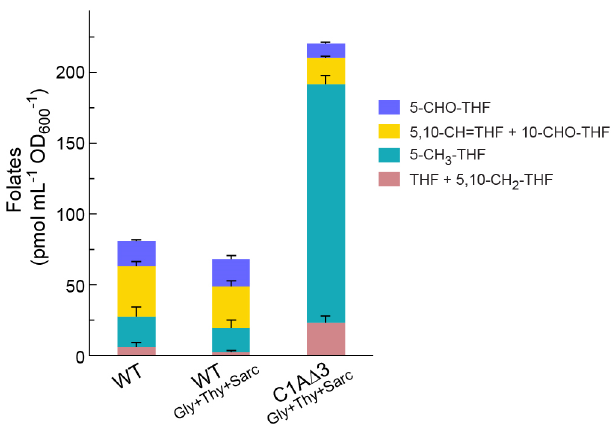
Figure 5. Intracellular content of THF and its C 1 derivatives. Strains were cultivated on a minimal medium with 10 mM glucose, supplemented with 1 mM glycine (Gly), 0.3 mM thymidine (Thy), and 1 mM sarcosine when indicated. Error bars represent standard errors, with n = 3.